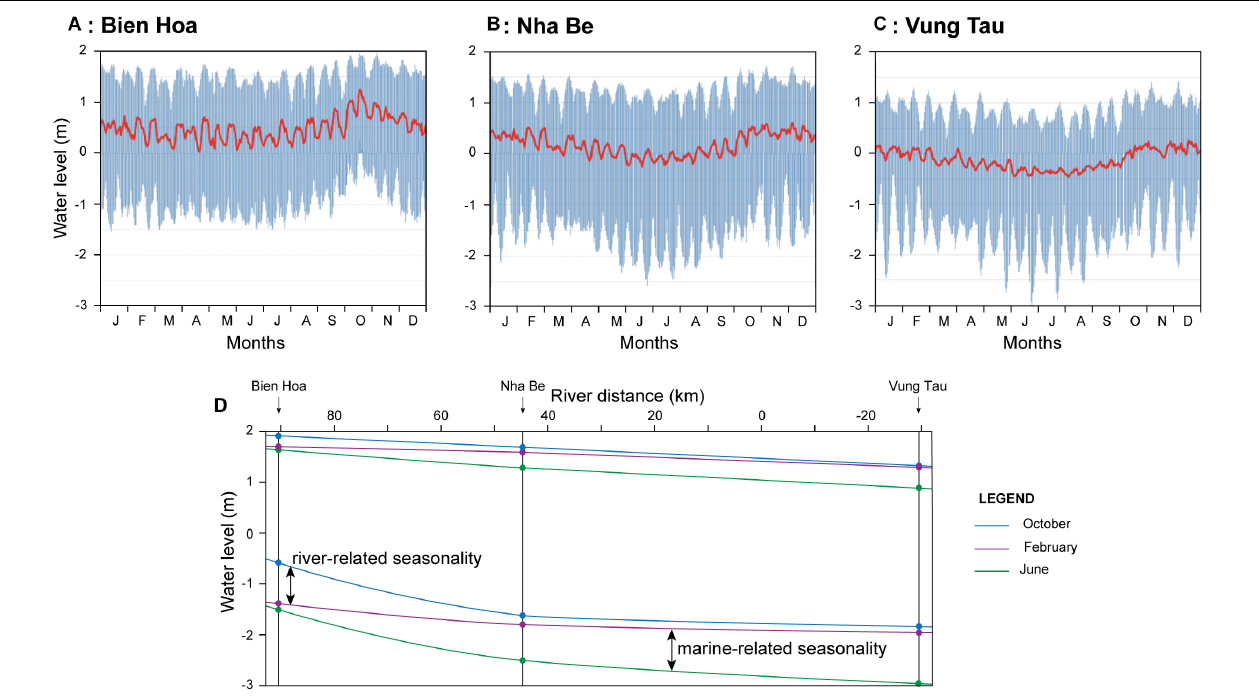
FIGURE 3 | (A–C) Water-level fluctuations at three stations in the study area (from the Southern Regional Hydrometeorological Center of Vietnam). (D) Reconstructed spring high and low tide water-level profiles in February, June, and October for the studied channel.